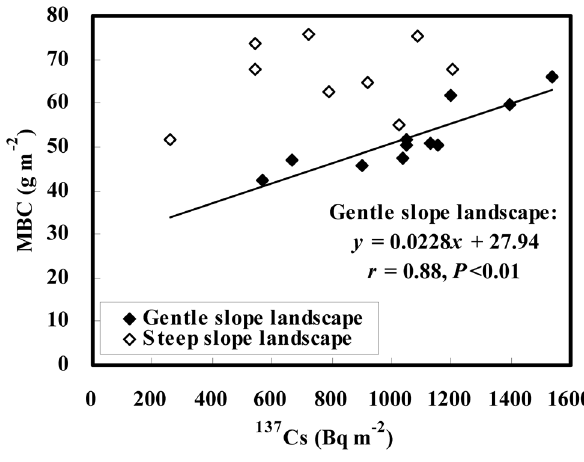
Figure 5. MBC contents vs. 137 Cs inventories in gentle and steep slope landscapes.